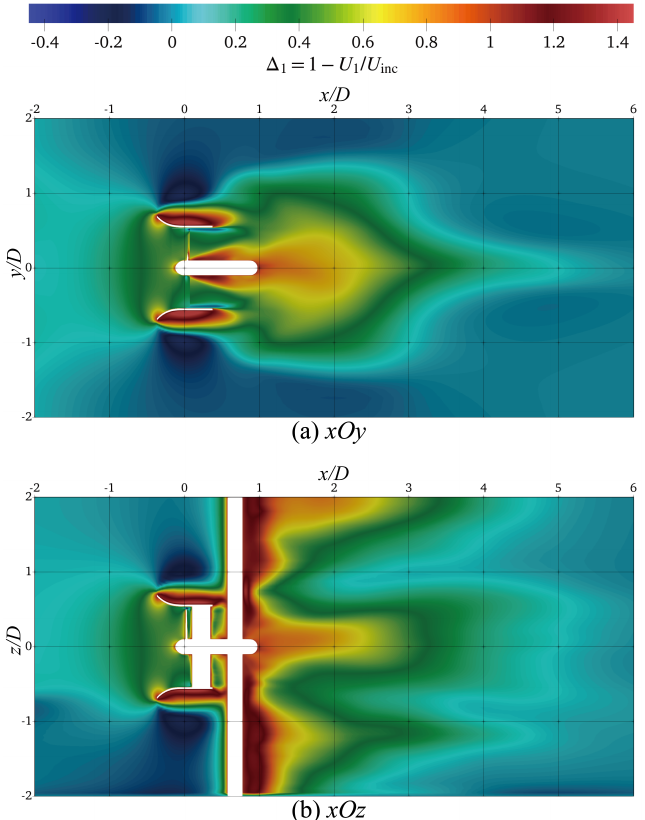
Figure 6. Contours of velocity deficit ( ∆ 1 ) on horizontal and vertical plane ( TSR = 3.6 )